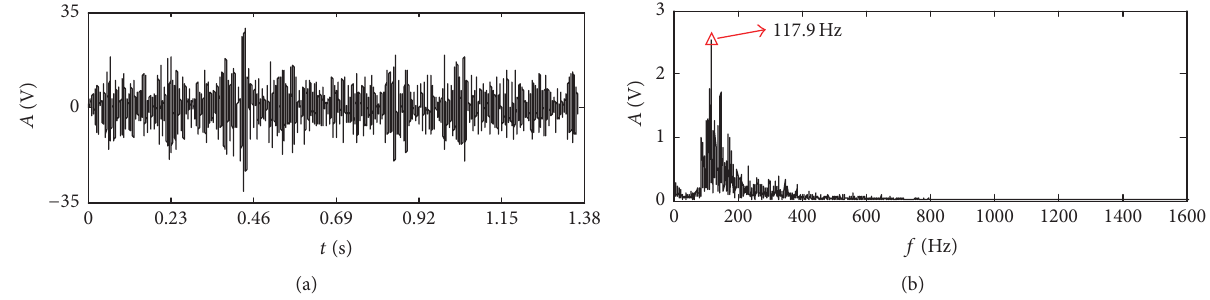
Figure 7: Detection results of the proposed method: (a) the output waveform of SR system; (b) the frequency spectrum.